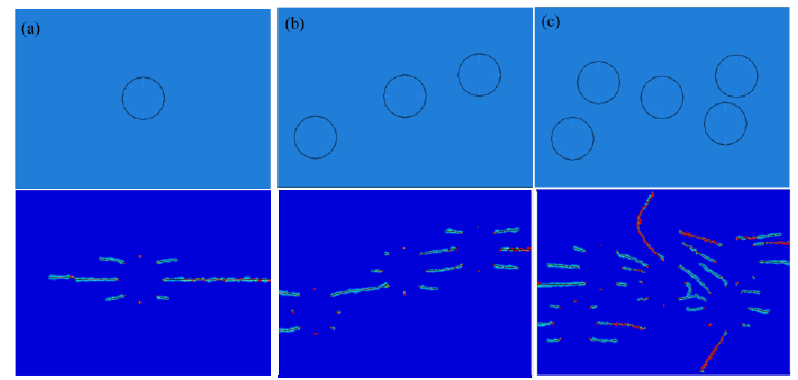
Figure 10. Crack propagation path in the coatings with various UNCs, ( a ) a single UNP; ( b ) three UNPs; ( c ) five UNPs.